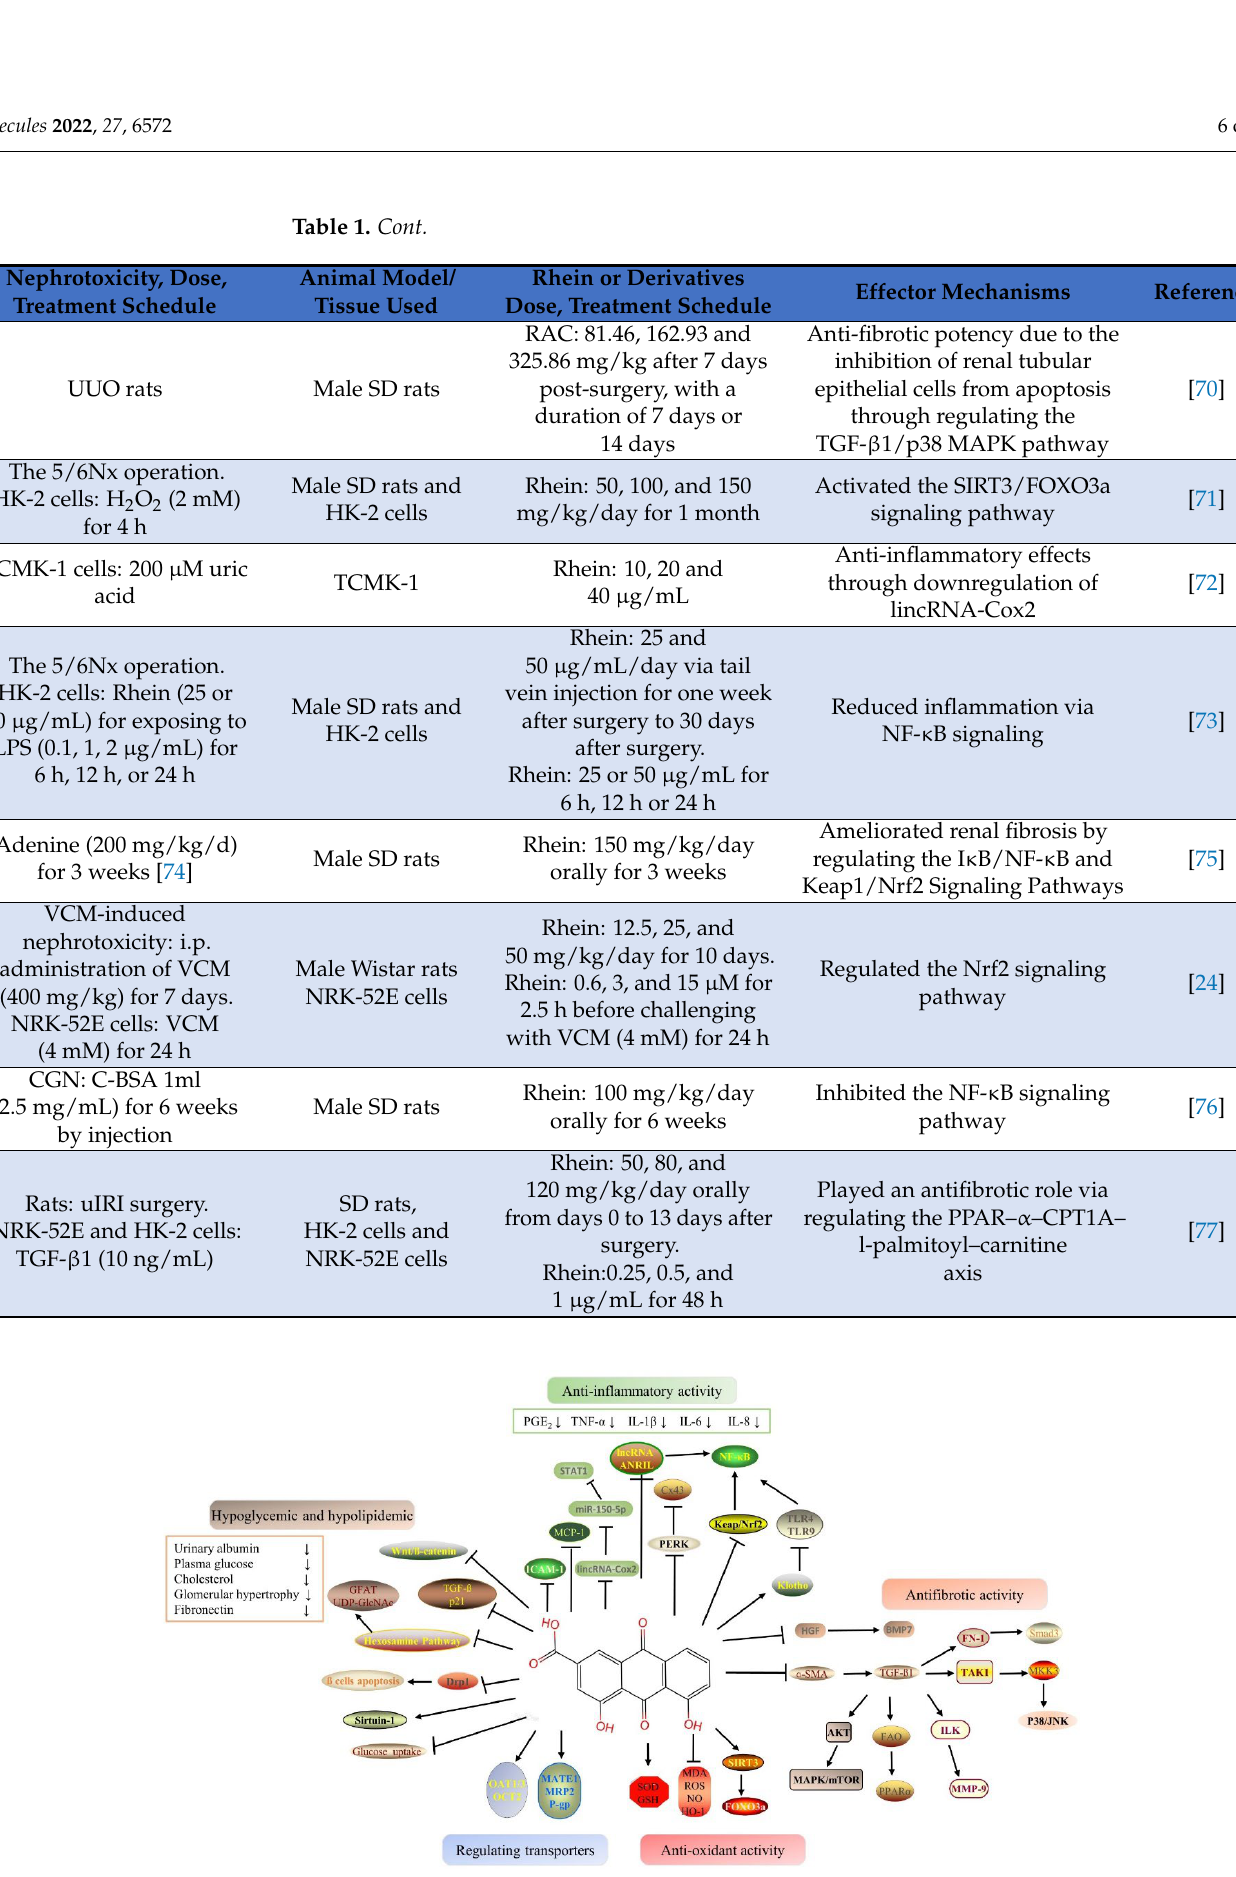
Figure 1. Signal pathway of the nephropropective effects of rhein.